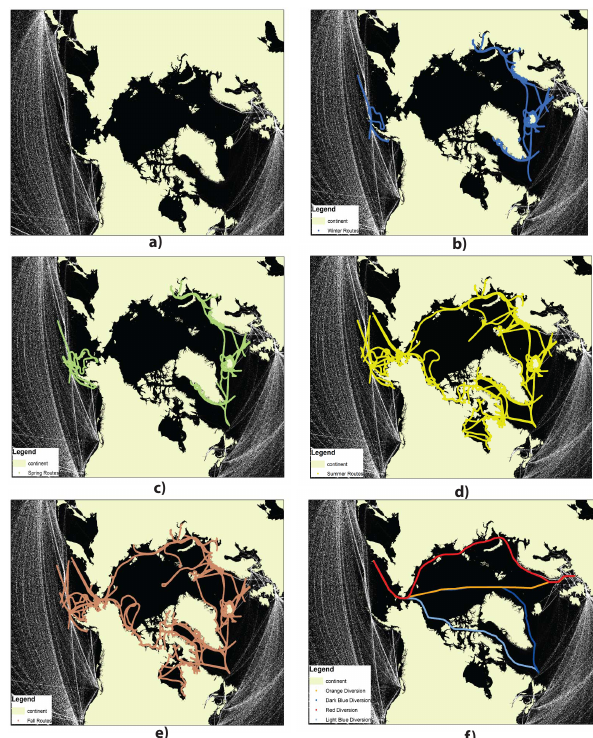
Fig. 1. Summary of seasonal traffic patterns for in-Arctic shipping: (a) global data prior to this work; (b) winter shipping 2004; (c) spring shipping 2004; (d) summer shipping 2004; (e) fall shipping 2004; and (f) potential global shipping diversion routes given navi- gable routes for diversion traffic open in